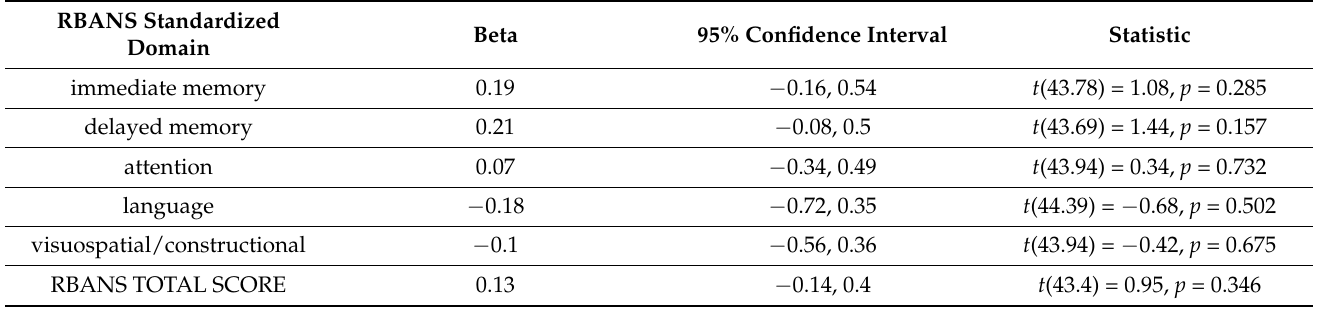
Table 4. Interaction between the diagnosis and session on cognitive performance. The beta signifies the interaction effect of schizophrenia and session in each RBANS domain while controlling for the participant